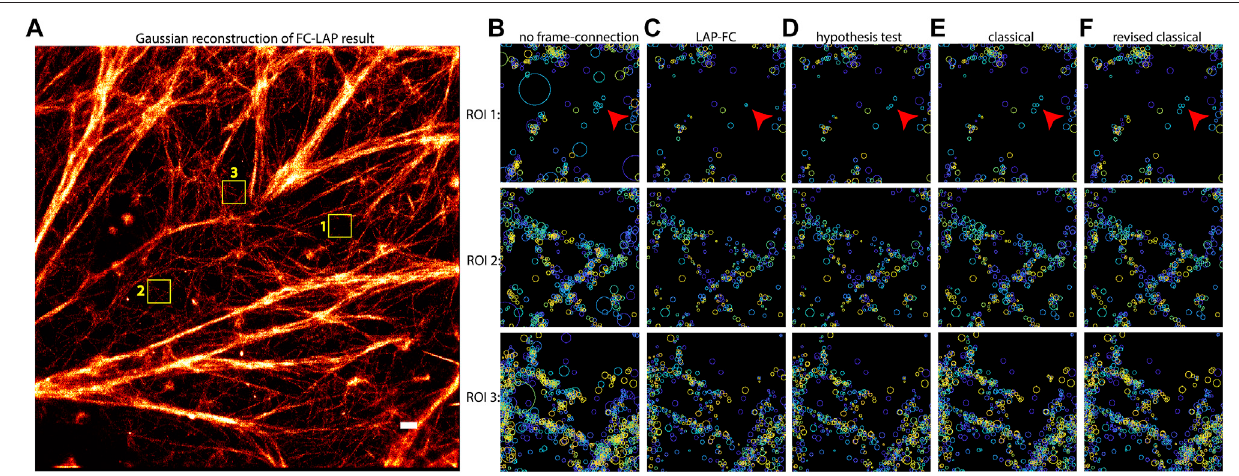
FIGURE 4 | Frame-connection results for actin micro fi lament localizations generated by multi-emitter fi tting. (A) Gaussian reconstruction image of the LAP-FC frame-connection results. Selected ROIs indicated by numbered yellow boxes in (A) are shown for the frame-connection results using (C) LAP-FC with a maximum pre- clusteringframegapof fi veframesandamaximumseparationof5timesthelocalizationerror; (D) thehypothesistestalgorithmwithamaximumframegapof fi veframes, amaximumseparationof1pixel,andalevel-of-signi fi canceof0.05; (E) theclassicalalgorithmwithamaximumframegapof1frameandamaximumseparationof 0.2 pixels; and (F) the revised classical algorithm with a maximum frame gap of fi ve frames and a maximum separation of 2 times the localization error. Scale bar (cid:2) 0.5 μ m. Localizations in (B) – (F) are displayed ascircles ofradius equal to thelocalizationerror centered on the estimated position and color-coded to indicate time, with dark blue indicating the start of the experiment and yellow indicating the end of the experiment. The red arrows in (B) – (F) ROI 1 point to a qualitatively interesting set of